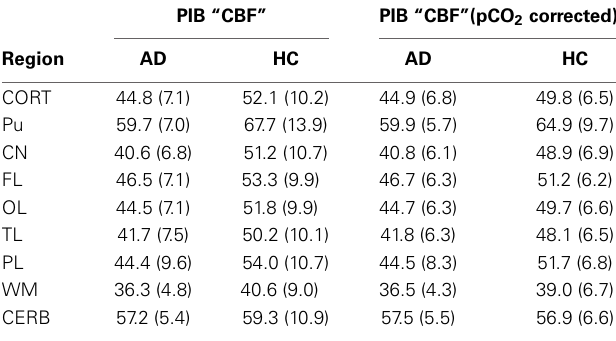
Table 5 | Regional surrogate CBF measures before and after correction for PCO 2 (Rodell et al.,